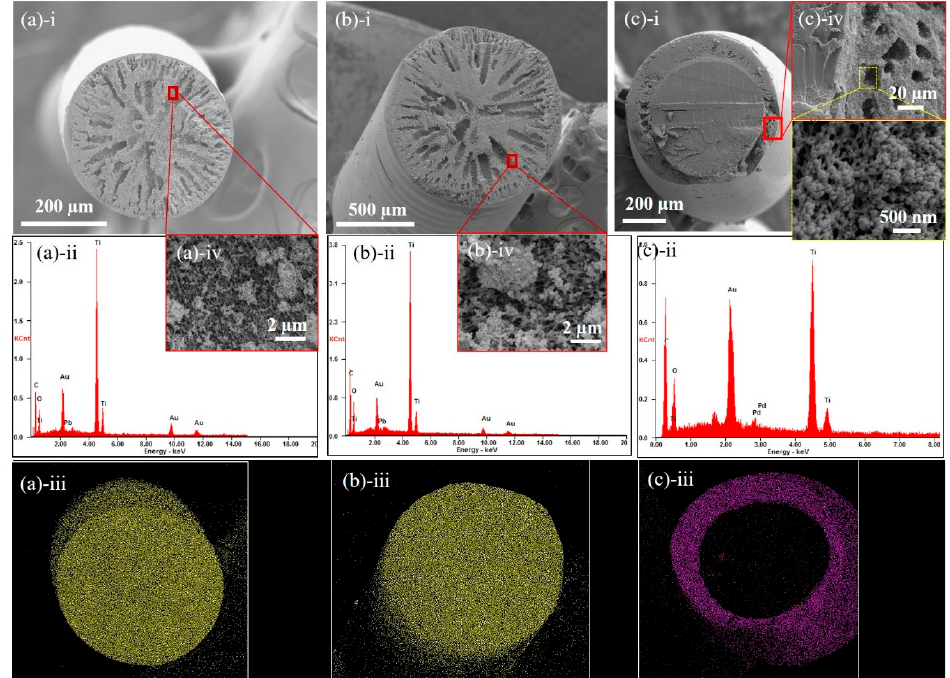
Figure 2. Morphological and compositional characterization of ( a ) D 5 , ( b ) D 10 , and ( c ) M-phase fibers with ( a-i to c-i ) the cross-sectional surface topology, ( a-ii to c-ii ) EDS of the surface showing the element identification, ( a-iii to c-iii ) distribution of TiO 2 , and ( a-iv to c-iv ) zoom-in regions in ( a-ii to c-i ) showing the dispersion of TiO 2 . Table 1. Physical properties of the as-fabricated fibers.